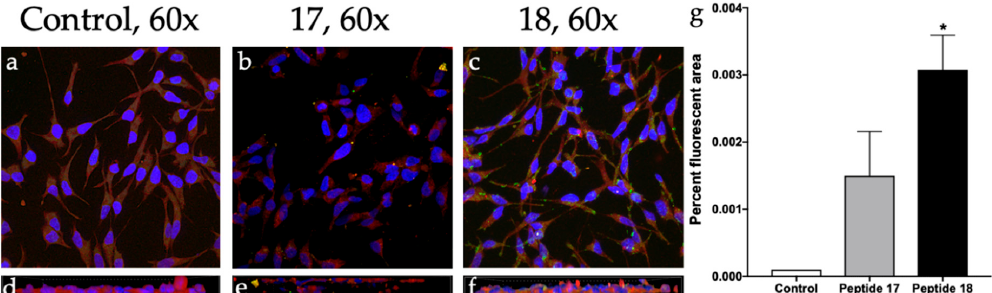
Figure 11. Comparative confocal microscopy of Fluorescent tagged peptide 17 and 18 . Control ( a ) shows no treatment; ( b ) shows FAM-linked disulfide cyclized targeting moiety in the peptide 17 ; ( c ) shows FAM linked amide cyclized targeting moiety in the peptide 18 ; ( d ), ( e ), and ( f ) are Z-slices of images in ( a ), ( b ), and ( c ); ( g ) shows the unpaired t -statistic reflects peptide 18 has higher binding to EDB-FN as compared to peptide 17 .